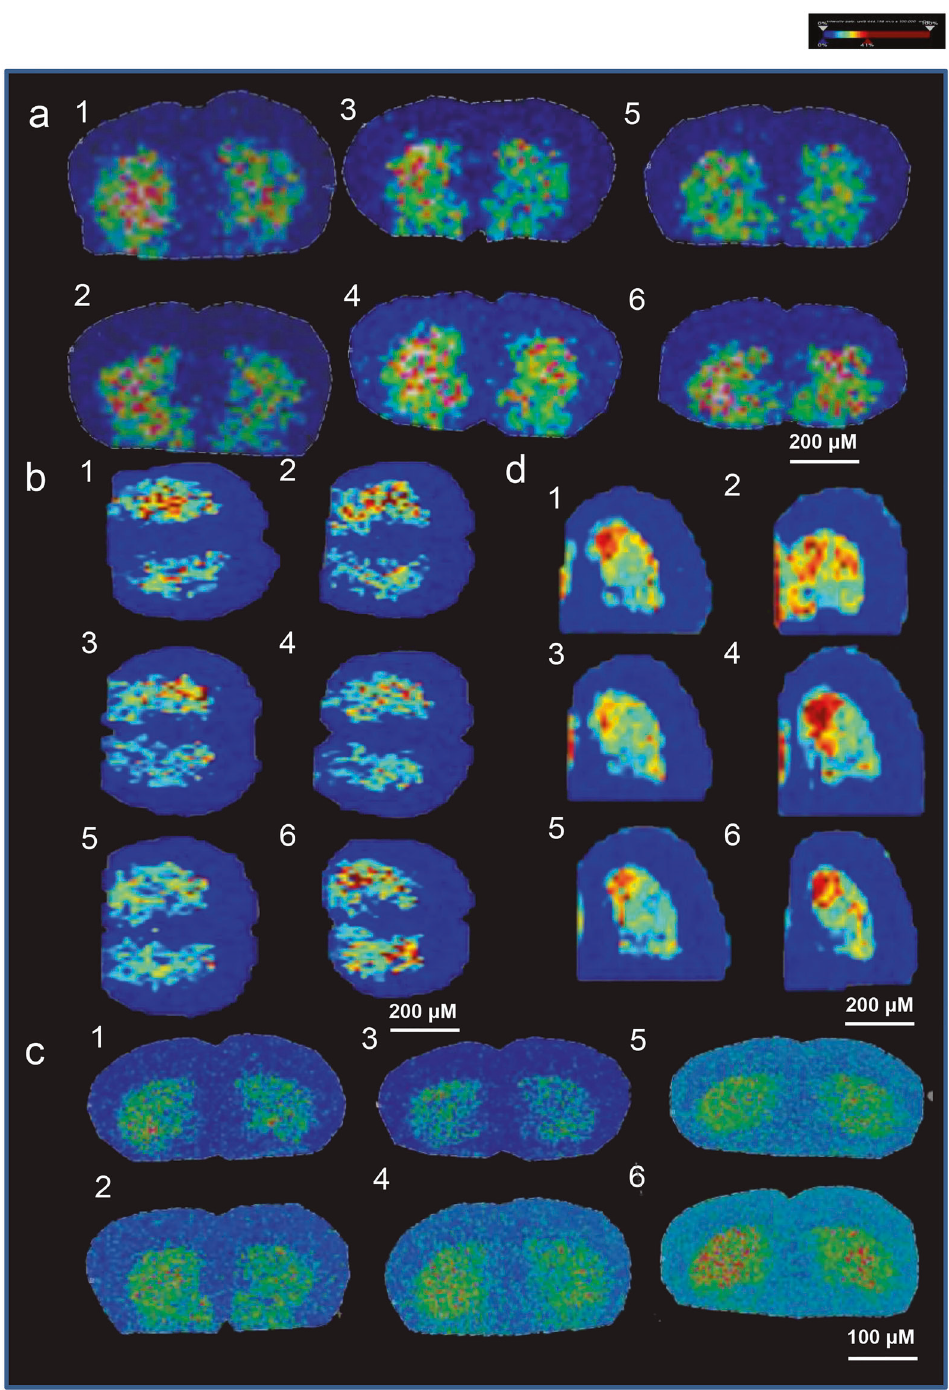
Fig. 6 BBR stimulated the production of dopamine in striatum in mice transplanted with E . faecalis or E . faecium: TMP-TFB-derivatized MALDI- MS images. a The relative abundance and distributions of dopamine with a spatial resolution of 200 µm. b Rescaled image from a with baseline subtraction and total ion count normalization. c The relative abundance and distributions of dopamine with a spatial resolution of 100 µm. d The relative abundance and distributions of dopamine in half brains from the same mice in c with a spatial resolution of 200 µm. All of them showed elevated levels of dopamine after BBR addition. (group 1: normal group; group 2: antibiotic treated only; group 3: antibiotics and E. faecalis ; group 4: antibiotics, E. faecalis , and BBR (200 mg/kg); group 5: antibiotics, E. faecium ; and group 6: antibiotics, E. faecium , and BBR (200 mg/kg)). Blue represents the decreased level and red represents the increased level. The striatal dopamine level in the mice receiving both E. faecalis and BBR was higher than that treated with E. faecalis only (group 3 vs. group 4). The striatal dopamine in the mice receiving both E. faecium and BBR was higher than that treated with E. faecium only (group 5 vs. group